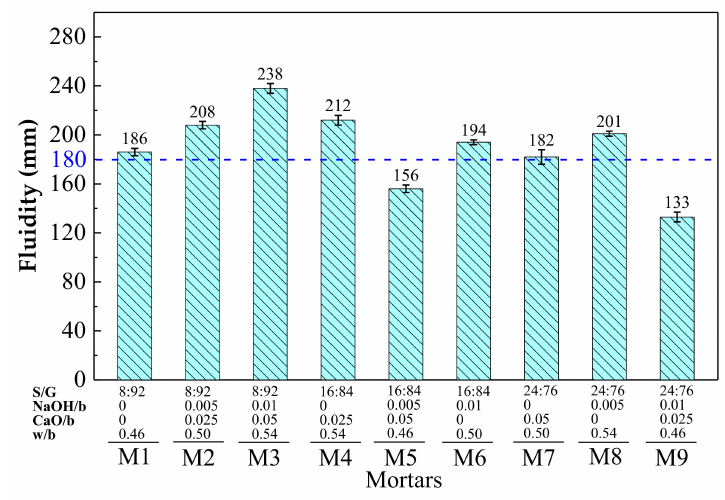
Figure 2. Fluidity of flesh mortars by orthogonal experiment.